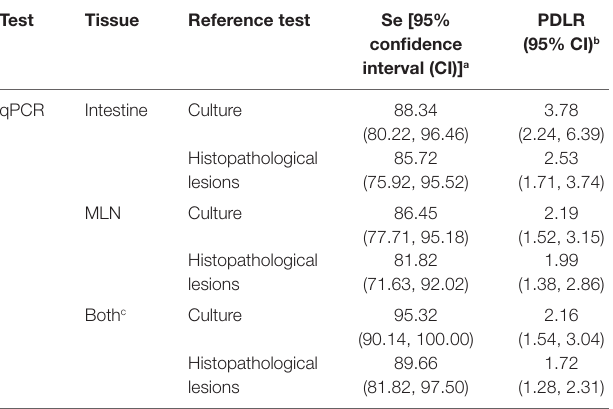
TaBle 2 | Performance characteristics of intestinal tissue and mesenteric lymph node (MLN) quantitative PCR (qPCR) with reference to tissue culture and tissue histopathological lesion